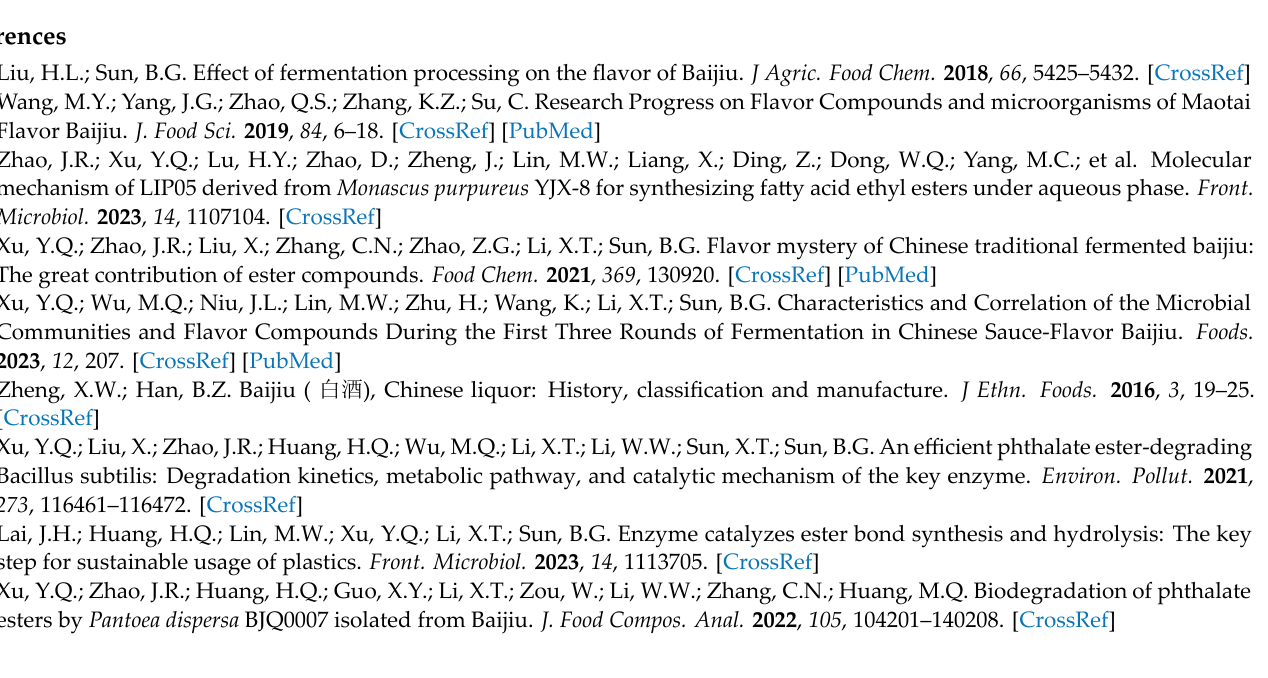
Table S1. Volatile flavor components identified by HS‑SPME‑GC‑MS in three colors of high‑ temperature Daqu